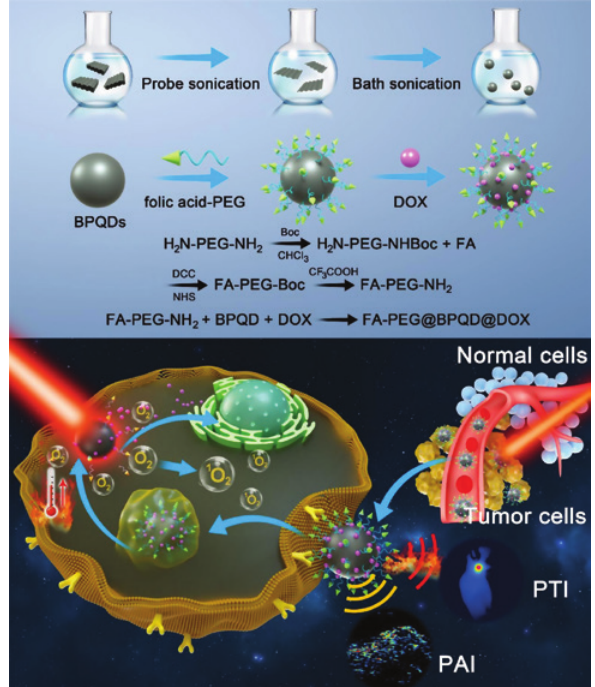
Figure 1: A schematic of the preparation of the FA-PEG@BPQD@ DOX nanocomposite and its anticancer mechanism of the combination of photodynamic therapy, photothermal therapy, and